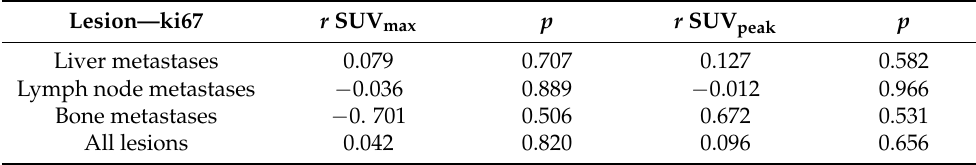
Table 5. Correlation between ki67, SUV max and SUV peak in different tumoral sites.